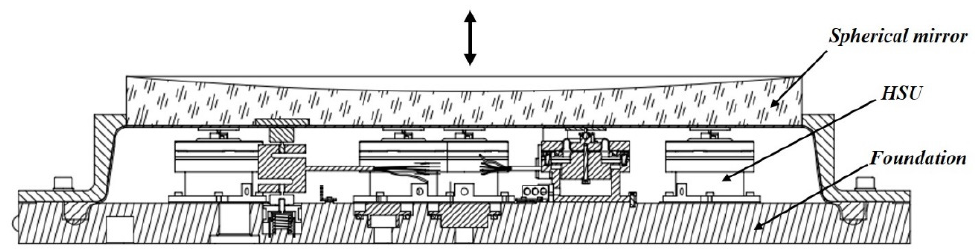
Figure 1. Schematic of a profile of a pneumatic–hydraulic composite support system. As depicted in Figure 2, nine HSUs are distributed uniformly in the circular direction. Each HSU in the inner circle and every two HSUs in the outer circle share one peristaltic pump. Each HSU in this combination possesses the same pressure of the working